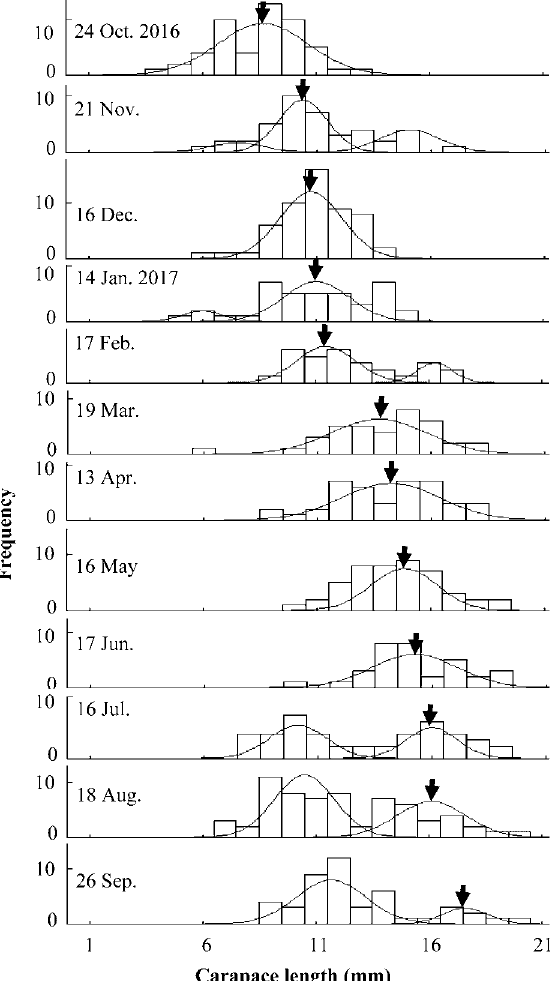
Figure 3. Length-frequency distributions of female Macrobrachium lamarrei collected from a wetland, northeastern Bangladesh during October 2016 to September 2017. Curves show the normal distributions, and arrows trace the progress of the cohort.